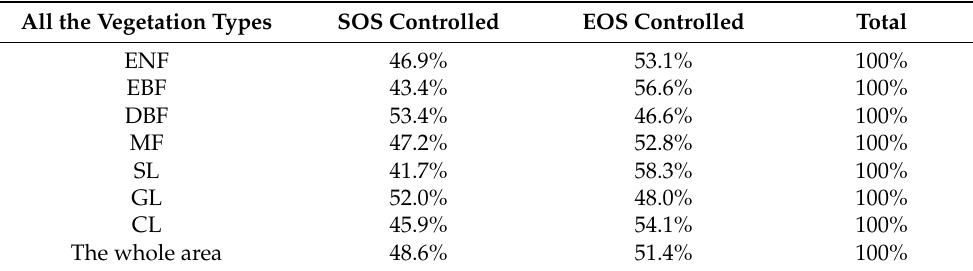
Table 5. The percentage of datasets in which LOS change was primarily attributable to the shift in